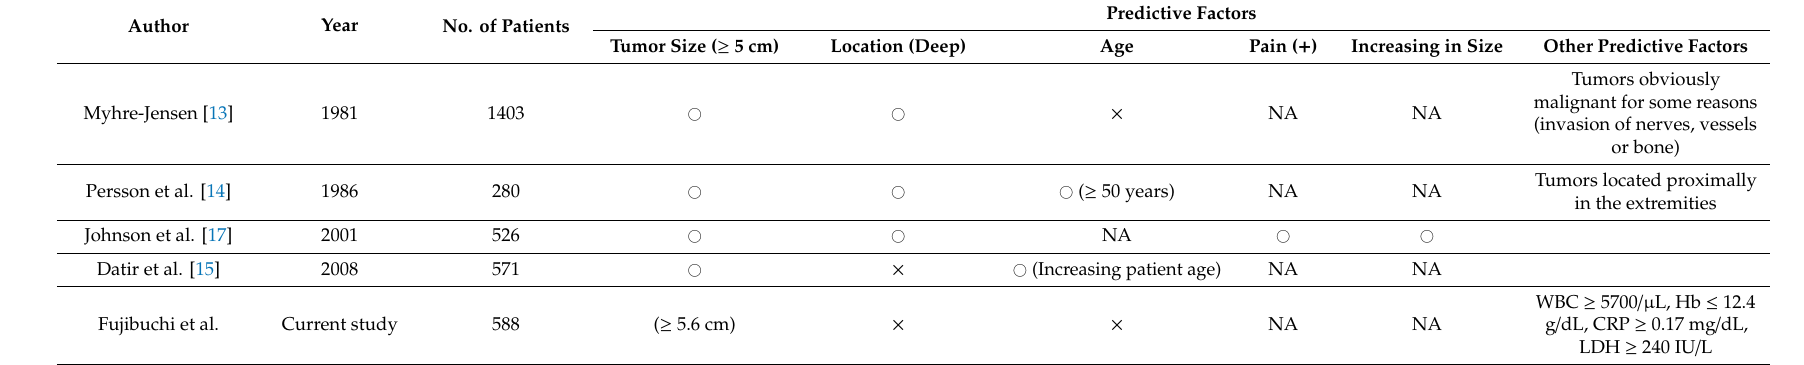
Table 9. Literature review of the predictive factors for